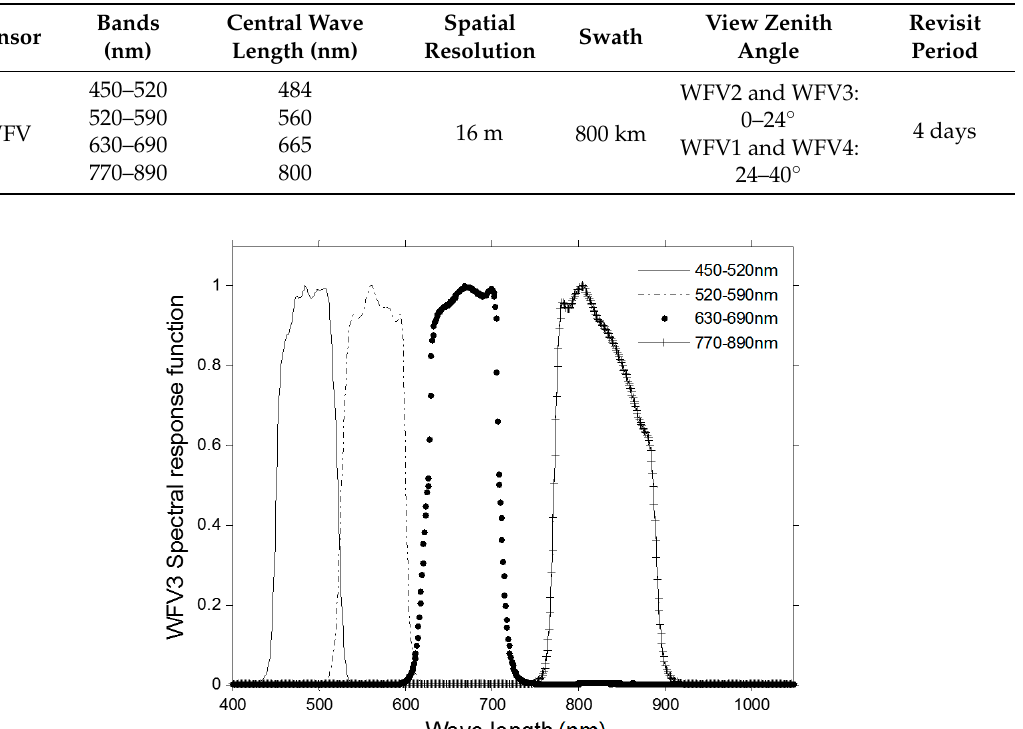
Table 1. Primary characteristics of the Wide Field Viewing cameras onboard Gaofen-1 satellite (GF-1/WFV).